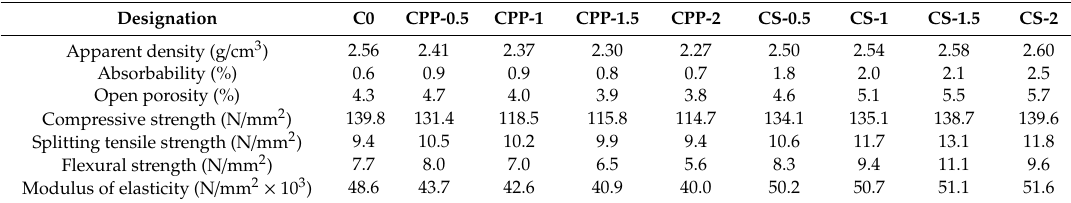
Table 4. Properties of hardened UHPC.